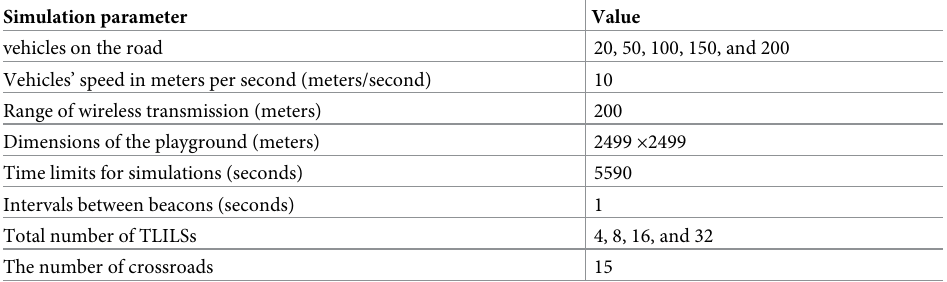
Table 5. Parameters for simulation to find the traffic light-inspired location service for VANETs. Simulation